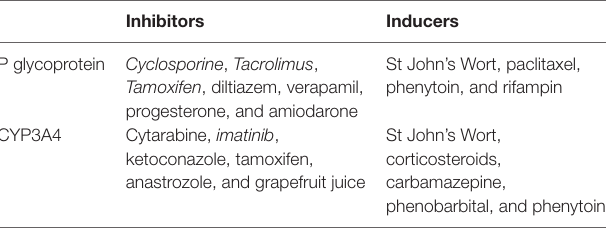
TABLe 3 | Common modulators of P-glycoprotein and CYP3A4 function